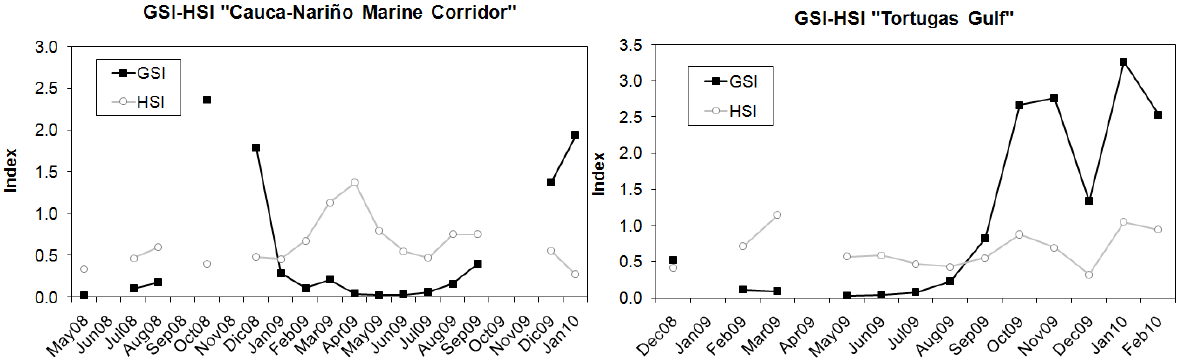
Fig. 4. Gonadosomatic and hepatosomatic indexes of C. mysticetus during 2008–2010 in the Tortugas Gulf and the Cauca-Nari˜no marine